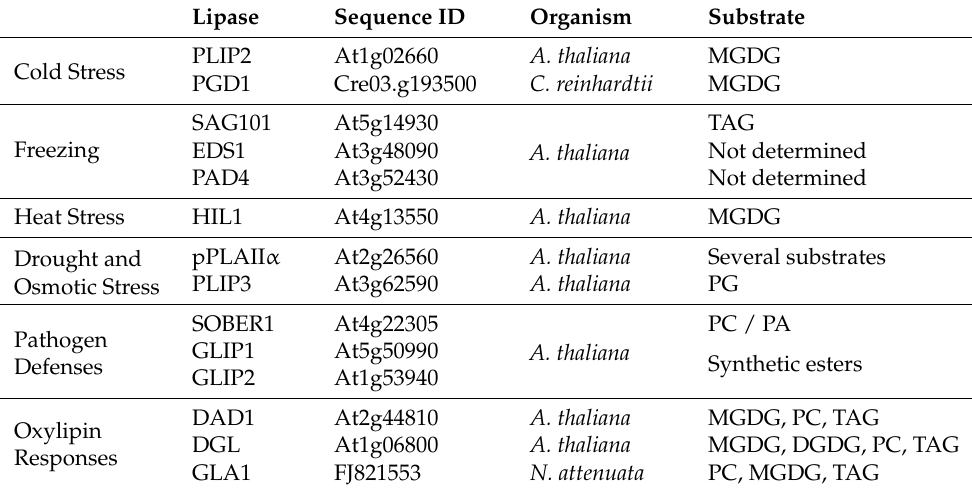
Table 1. Examples of lipases involved in the plant stress response